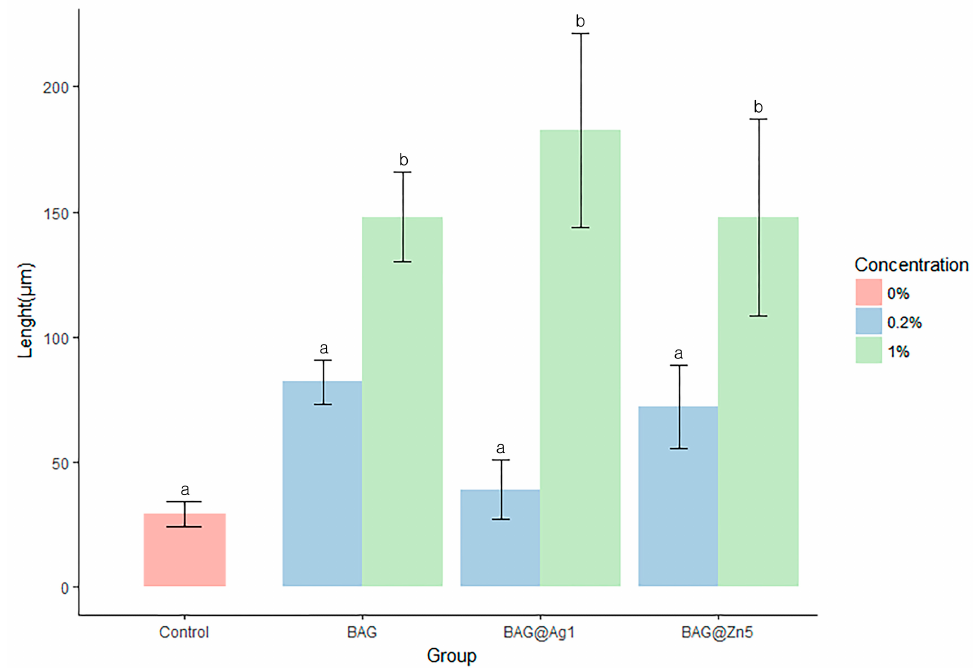
Figure 6. Comparison remineralization length of the BAG and ion (silver or zinc)-doped BAG orthodontic bonding primer using the ImageJ analysis. Duncan’s Multiple Range Test ( n = 9). The same letters indicate that the p -values are not significantly different ( p < 0.05). Error bars indicate the ± standard deviation.